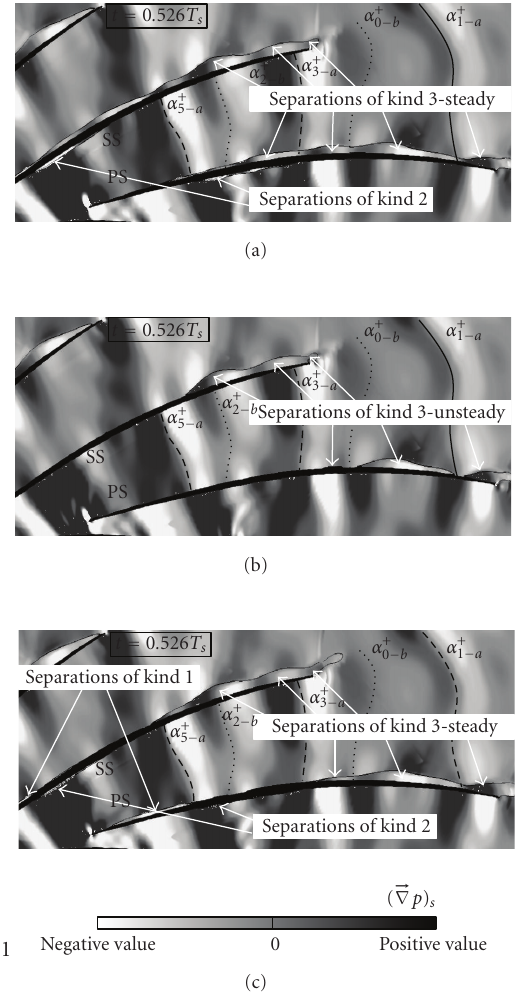
Figure 17: Pressure gradient in the flow direction at 2% (a), 50% (b), and 98% (c) section height black contour: zero–isovalue of the azimuthal velocity V θ